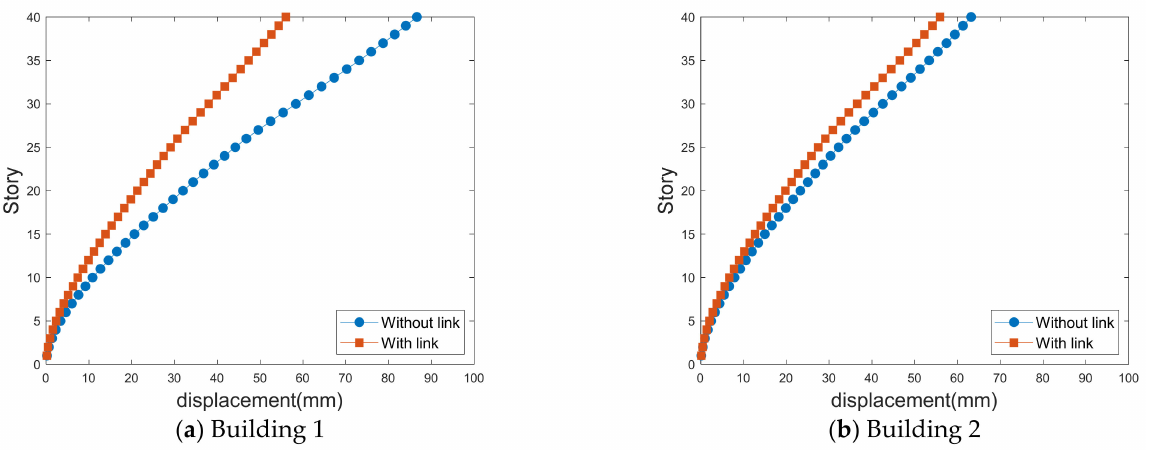
Figure 16. Crosswind-induced lateral displacement with a large gap